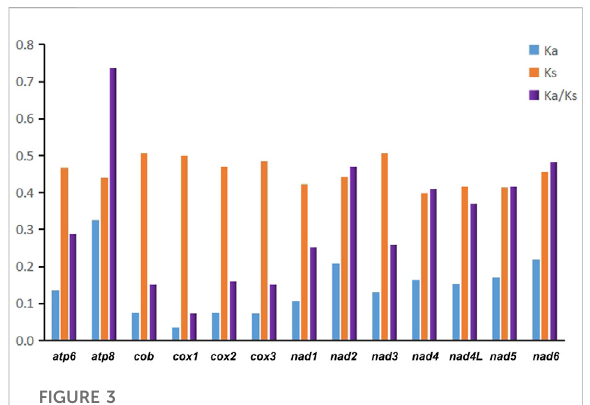
FIGURE 3 The K a (non-synonymous substitutions), K s (synonymous substitutions), and K a /K s values of each PCGs in Pentatomidae.